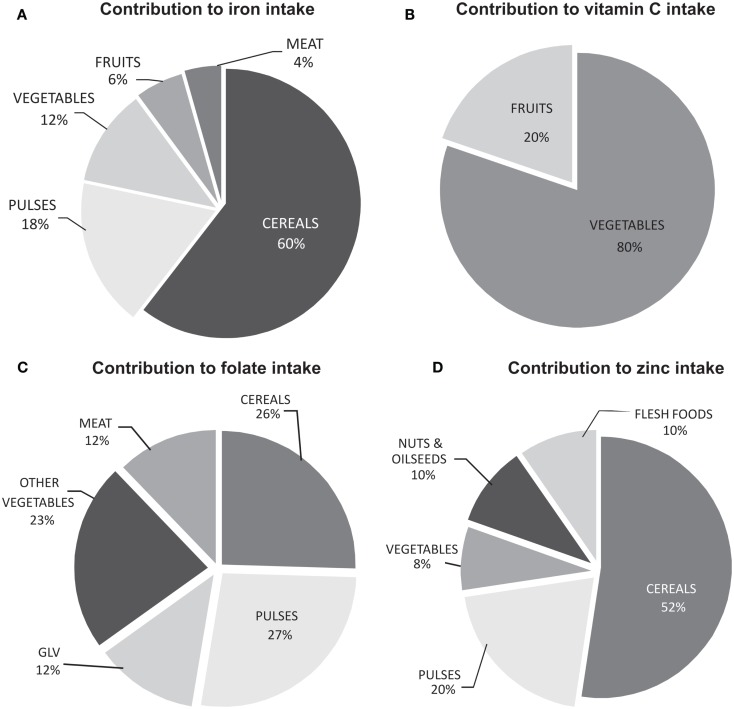
Contribution of different food groups in meeting the daily requirement of micronutrients (A) iron, (B) vitamin C, (C) folate, and (D) zinc. Calculated using the model diet (8) and the food composition database (9).